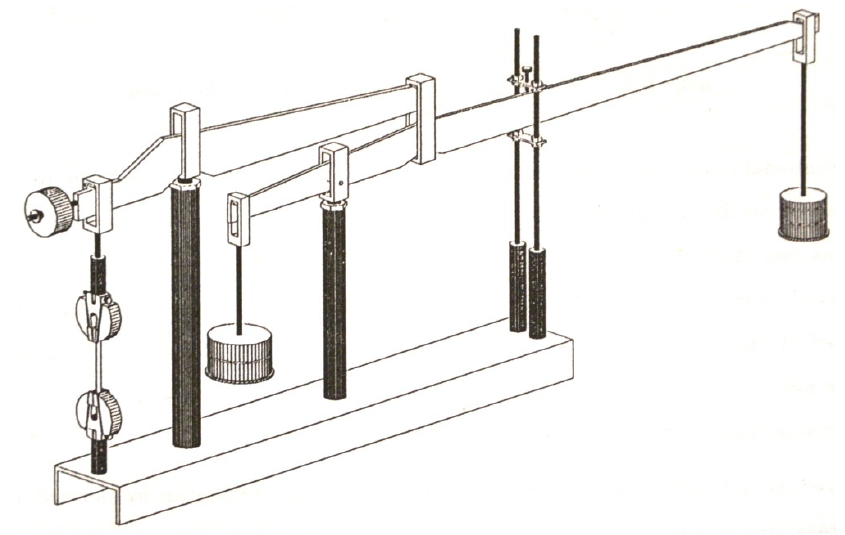
Figure 4. Experimental testing device. Double lever device.